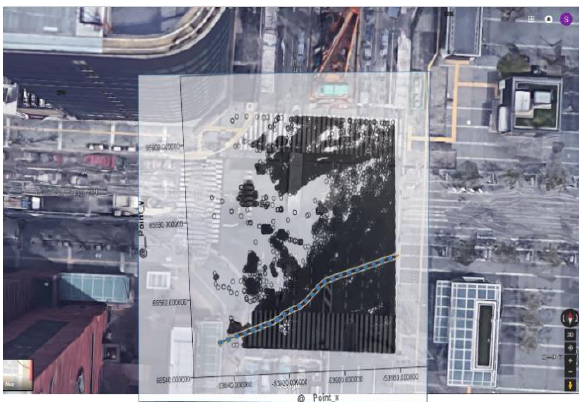
Figure 8. The most common path that pedestrians took detected on the multi-directional crossing area interpreted by the trend- line of the loess regression curve